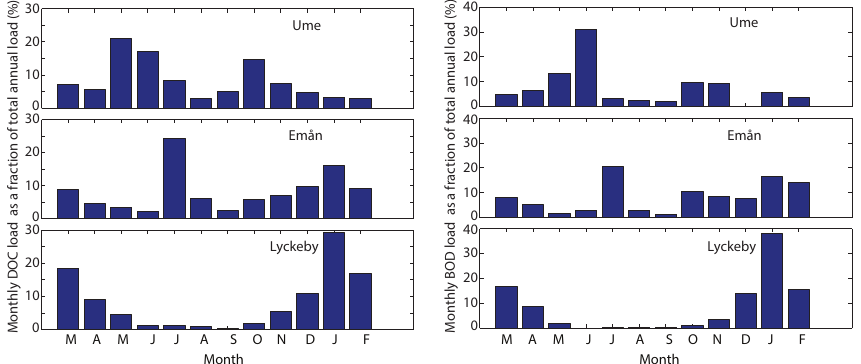
Figure 4. Mean monthly loadings of dissolved organic carbon and biological oxygen demand, represented as a percent of the total annual loading for each